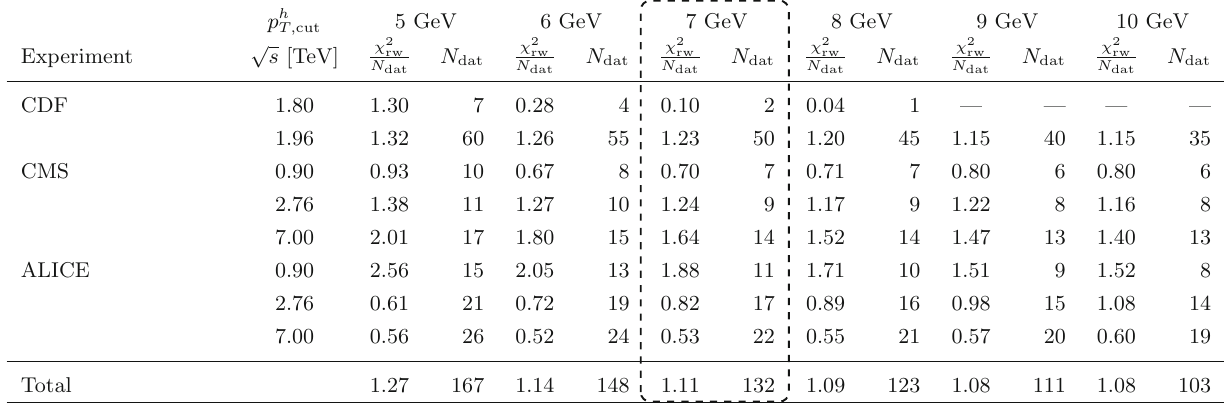
= 7 GeV . Our baseline is p h T , cut T , cut p h 5 GeV T, cut